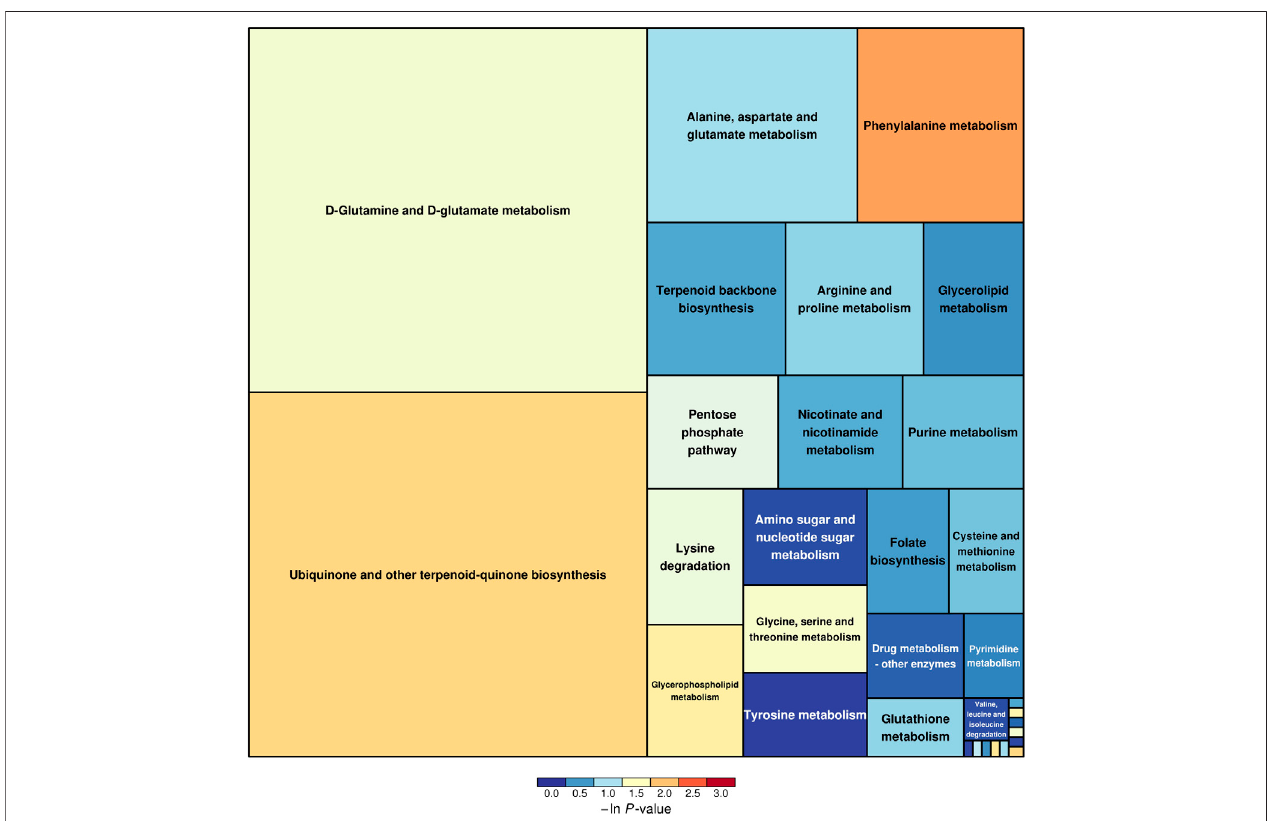
FIGURE 3 | Results of metabolic pathway analysis are displayed in a rectangular tree diagram. Each block in the rectangular tree diagram represents a metabolic pathway. The sizes and colors of the block represent pathway enrichment and pathway impact, respectively. Large sizes and dark colors represent major pathway enrichment and high pathway impact values,